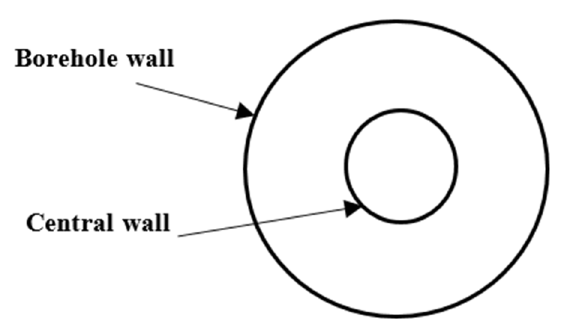
Figure 13. Cross section of coaxial borehole heat exchanger.